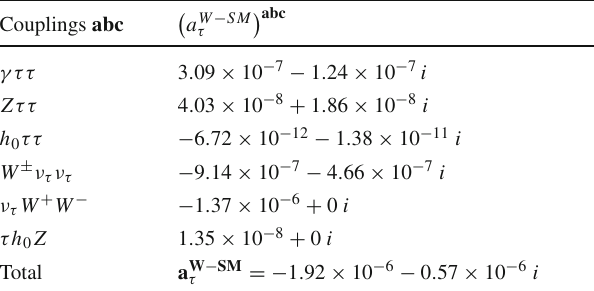
Table 12 Partial contributions to a W − SM τ . abc denotes the different particles running in the loop of the vertex Z τ + τ − Couplings